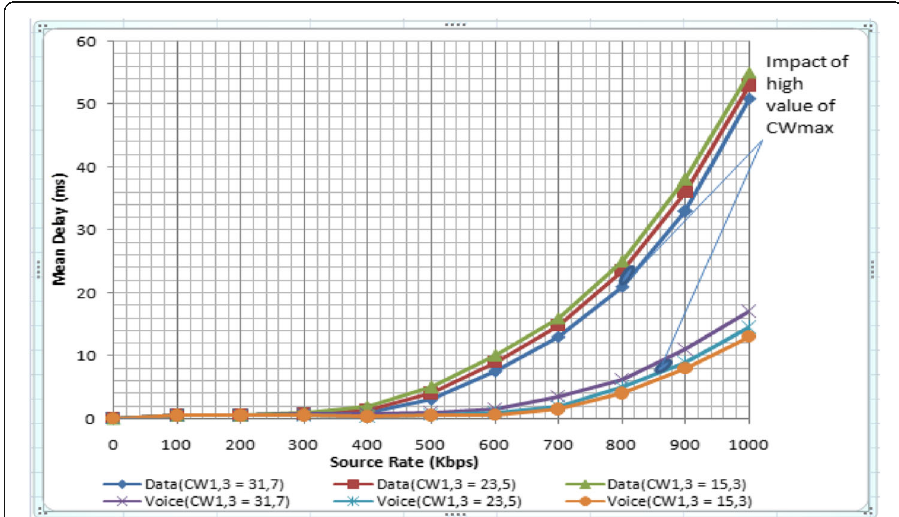
Fig. 15 Average delay of BE and VO traffic at varied CW size versus source